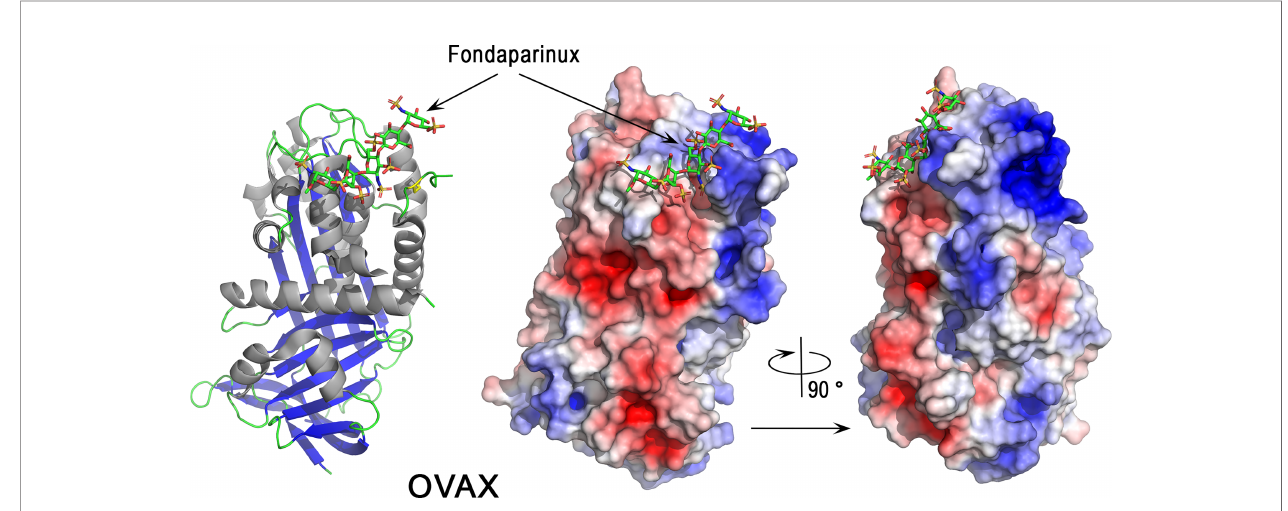
FIGURE 7 | 3D structure of the serpin ovalbumin-related protein X (OVAX). The left panel corresponds to the cartoon representation of 3D structure of chicken OVAX while the right panel shows the color-coded electrostatic potential molecular surface. Color scheme ranges from red (negatively charged regions) to deep blue (positively charged regions). Fondaparinux is shown in stick representation (carbon: green, oxygen: red, sulfur: orange, nitrogen: blue). The fi gure was prepared using Pymol software (48) and APBS (Adaptive Poisson-Boltzmann Solver) plugin (49) for electrostatic calculations using X-ray atomic coordinates of OVAX kindly provided by F. Coste (CBM, CNRS, UPR4301, Orle ́ ans, France) prior to the release of these data in the PDB under 7QRN accession